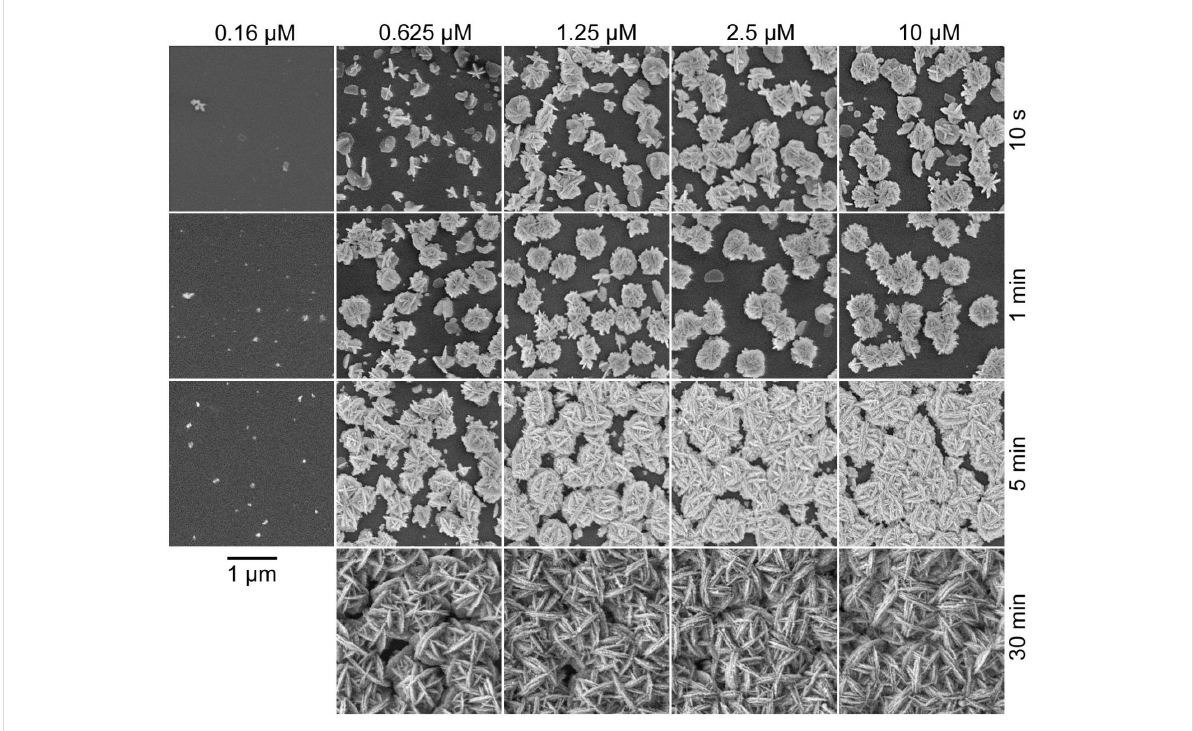
Figure 2: SEM images of silver EGNPs grown from different starting DNA concentrations of 0.16, 0.625, 1.25, 2.5, and 10 µM (as labelled above the columns). The reaction time was 10 s, 1 min, 5 min, or 30 min, respectively. The scale bar of 1 µm, as indicated, is valid for all parts of the figure. The images were taken at normal